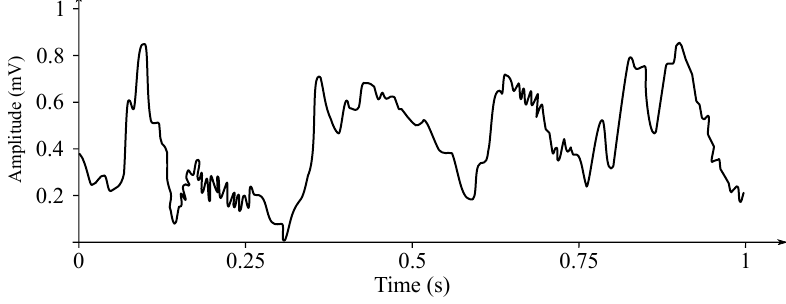
Figure 9. Example of the ECoG